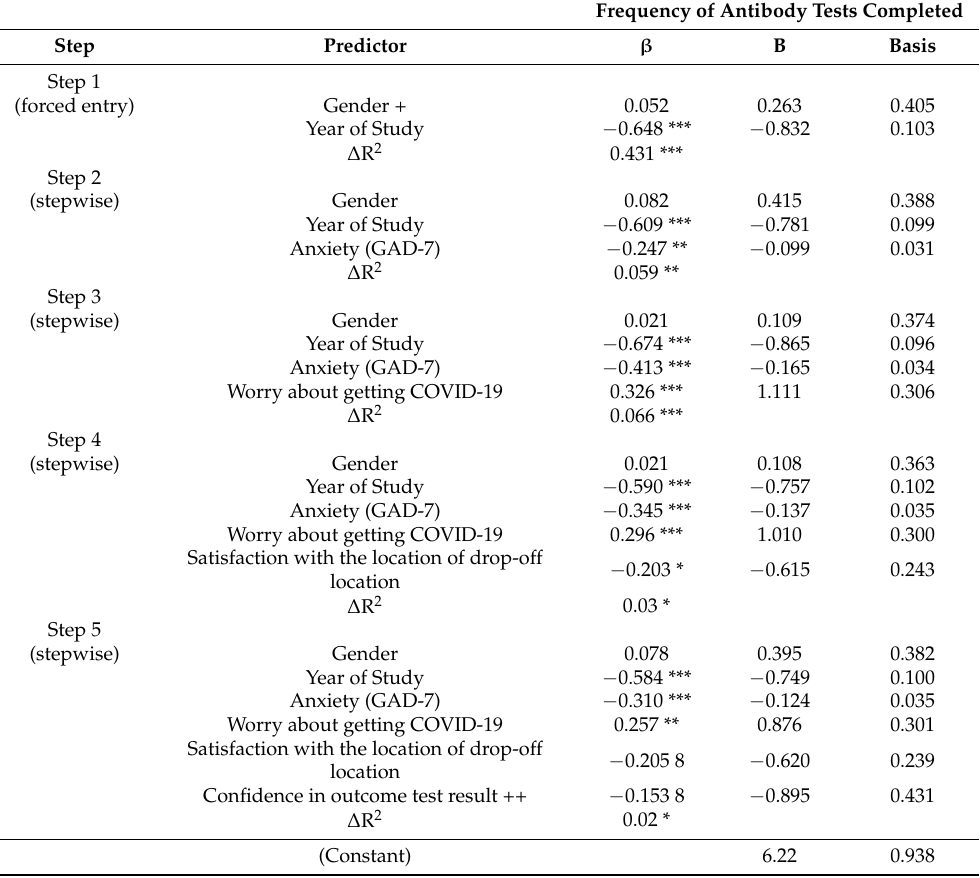
Table 9. Summary of hierarchical regression analysis of variables predicting number of antibody tests taken ( n =